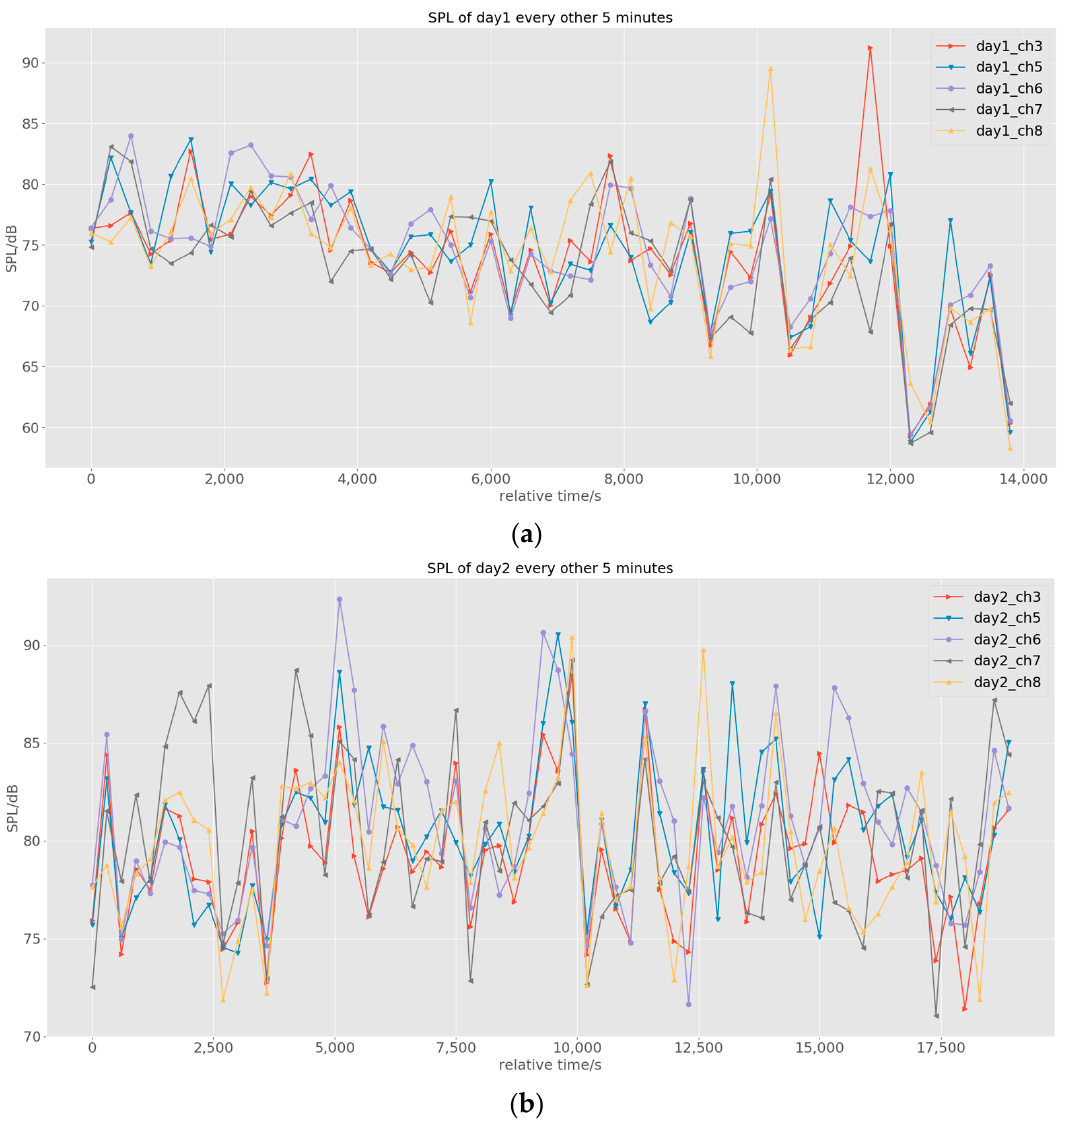
Figure 9. Extracted SPL every other five minutes during the two days from different microphones: ( a ) SPL every other five minutes from day 1; ( b ) SPL every other five minutes from day 2.